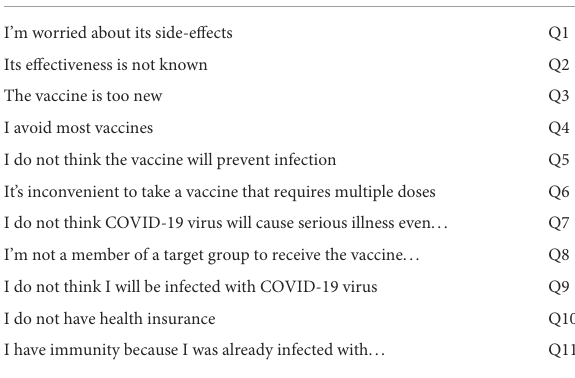
TABLE 5 Quotes from those not willing to participate in a COVID-19 vaccination